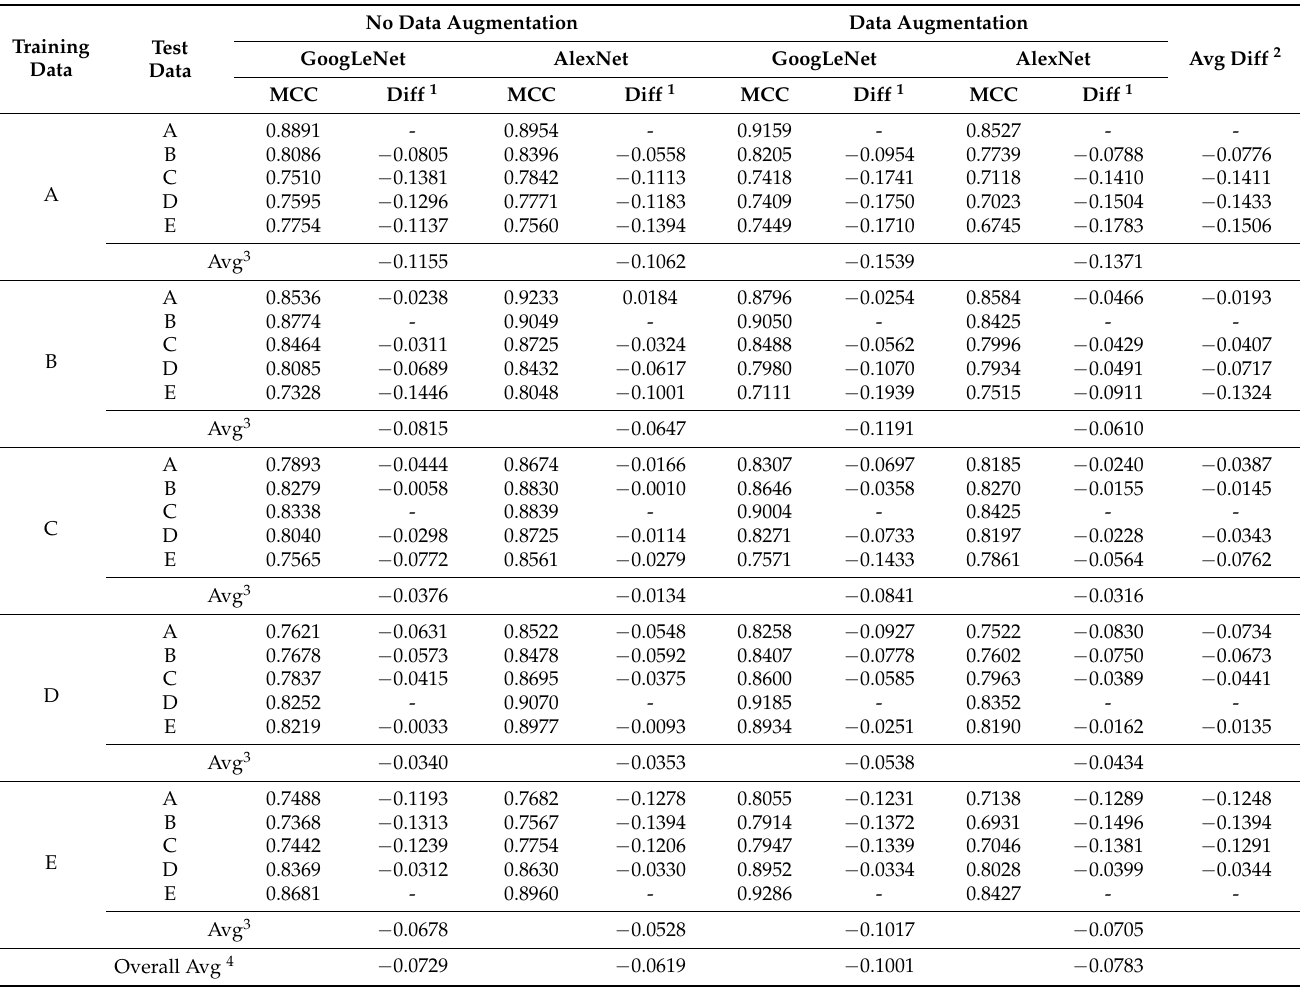
Table 3. Tree species classification accuracy results for images taken at different focal points between the training and test data. The epoch number was 200 for all